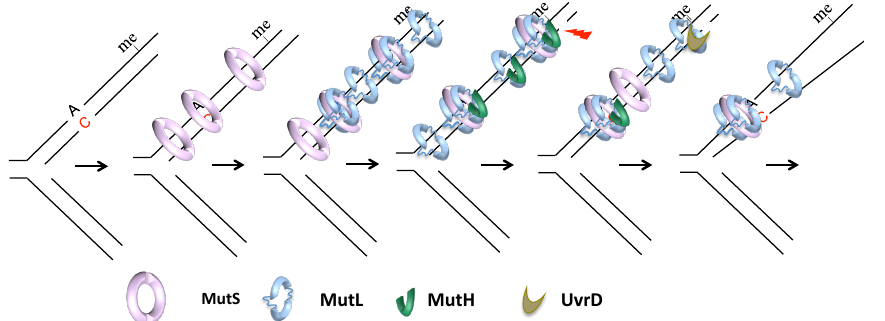
Figure 1. MMR mechanism of E. coli . Replication error repair in E. coli is presumed to be carried out by the following sequence of steps: MutS dimer binds to a mismatch; stabilization of the ATP- bound MutS state; MutS slides away from the mismatch; additional copies of MutS load onto the mismatch -> one or several MutL dimers bind to sliding MutS; MutS or MutL can dissociate from diffusing MutS–MutL complexes -> MutH binds to diffusing MutL or MutS–MutL complexes; physical interaction between MutH and MutL activates MutH endonuclease activity; activated MutH incises the newly synthesized strand at the unmethylated d(GATC) sequence -> MutL and UvrD assemble near the single-strand break -> binding of UvrD to MutL allows unwinding of the portion of the newly synthesized strand beyond the mismatch -> the unwound portion of the new strand is resected; DNA polymerase resynthesizes the excised strand, and DNA ligase seals the nick (not shown); me, methylated GATC sequence (old